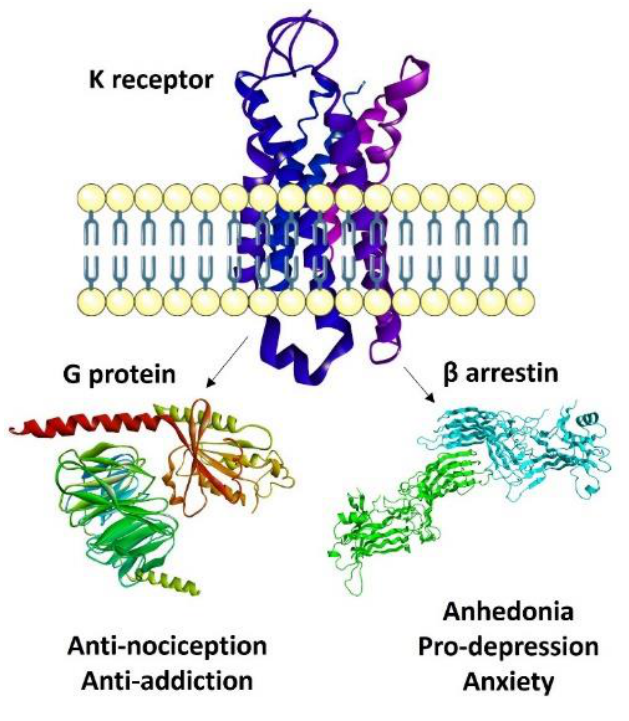
Figure 7. Activation and linked effects of G-protein and arrestin .